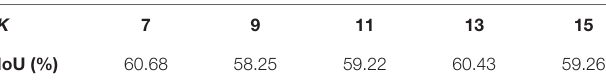
TABLE 5 | Performance comparison using different scales of filter in the skip